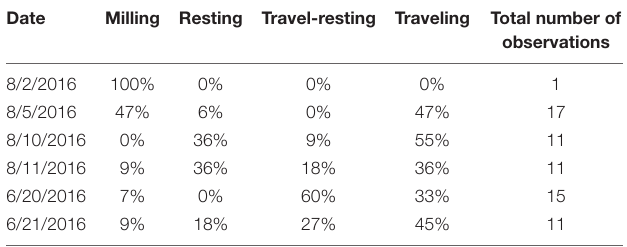
TABLE 5 | Percentage of observations during each vessel-based survey that contained Hawaiian spinner dolphins in each behavioral state (milling, resting, travel-resting, or